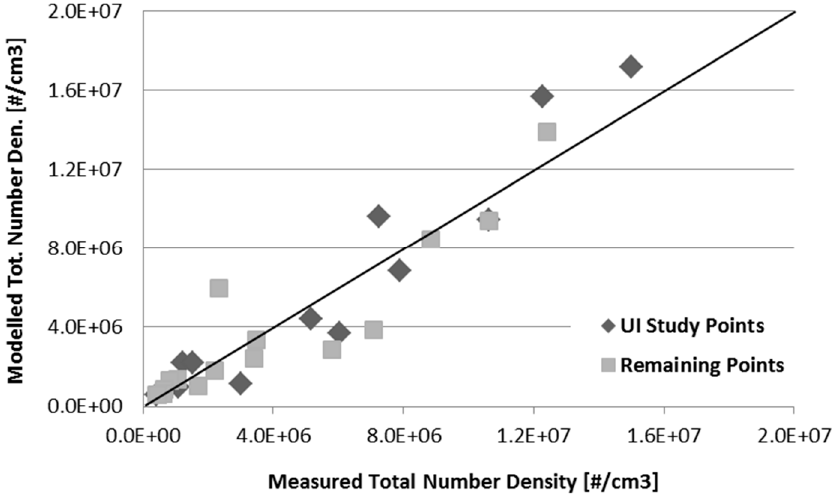
Figure 14. Comparison of measured and modelled levels of total particle number density for the running conditions investigated in this